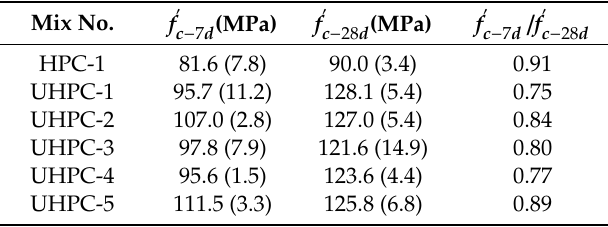
Table 9. Development of compressive